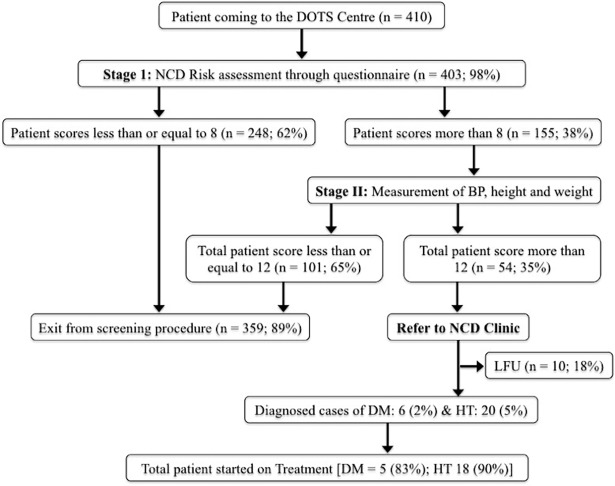
Flow of participants through the screening process.